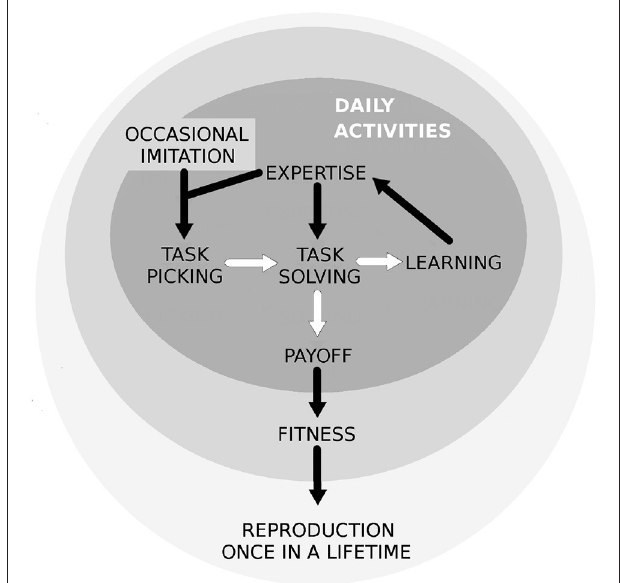
FIGURE 1 | A schematic figure of our model’s main events and effects. White arrows represent events of the days. The black arrows represent either consequences or effects. For example, task solving is always followed by learning in the model, and learning enhances one’s expertise in the given task, E ij ( t ). One’s expertise then both increases her task solving efficiency, and effects her task picking